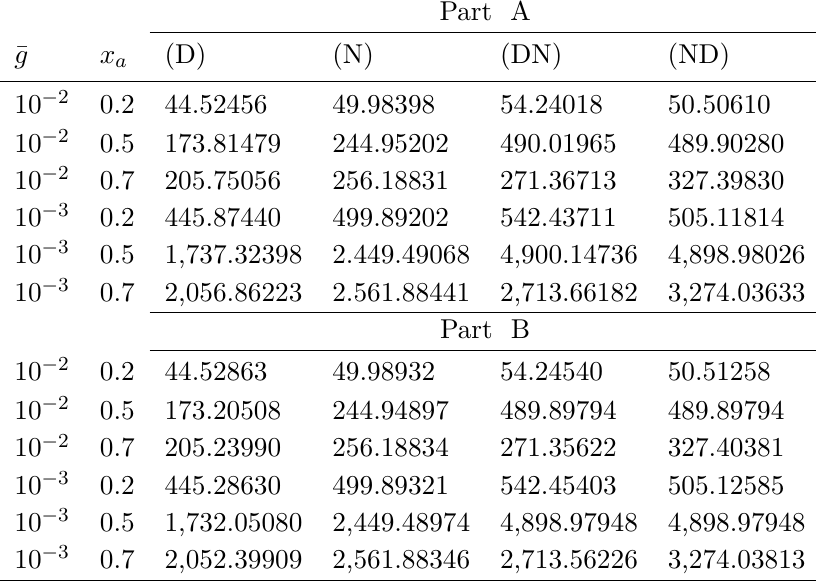
Table 1 . Upper bound values for the time τ (j) a in the case of the perpendicular position dispersion, subjected to the small displacements condition, considering different values for the dimensionless parameters ¯ g and x a . Parts A and B of the table, respectively, show the results numerically obtained from the graphs in figure 8 and the results using eq. (3.44) for Dirichlet (D), Neuman (N), Dirichlet- Neumann (DN) and Neuman-Dirichlet (ND) boundary